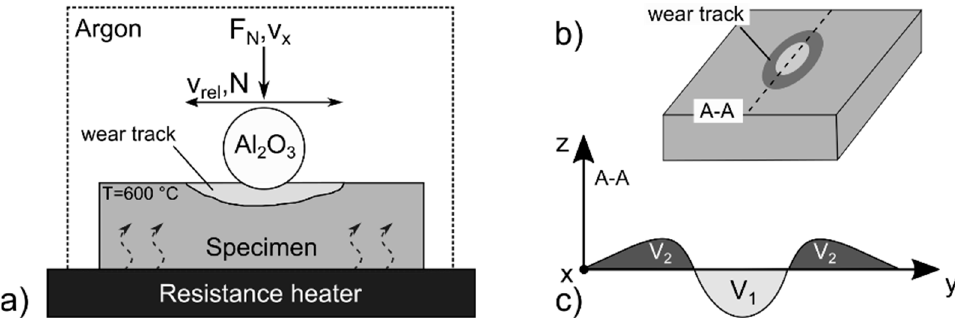
Figure 2. Schematic drawing of the sliding wear test setup ( a ) and the generated wear tracks ( b , c ).